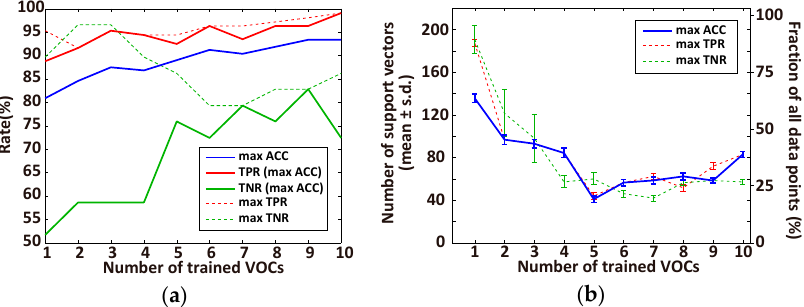
Figure 6. Dependency of the performance of SVM diagnosis on the number of trained VOCs of the data set (lung cancer patients, n = 107; healthy individuals, n = 29, oversampling healthy samples, n = 78). ( a ) Best accuracy (ACC, blue line) with the corresponding true positive rate (TPR, solid red line) and true negative rate (TNR, solid green line) within all combinations of each number of trained VOCs (from 1 to 10). The dashed red and green lines represent the best TPR and TNR, respectively. ( b ) The number of support vectors that are used in the classifier in ( a ) for the best ACC (blue), TPR (red), and TNR (green). Left and right y-axes represent the actual number of data points and fraction of all data points,